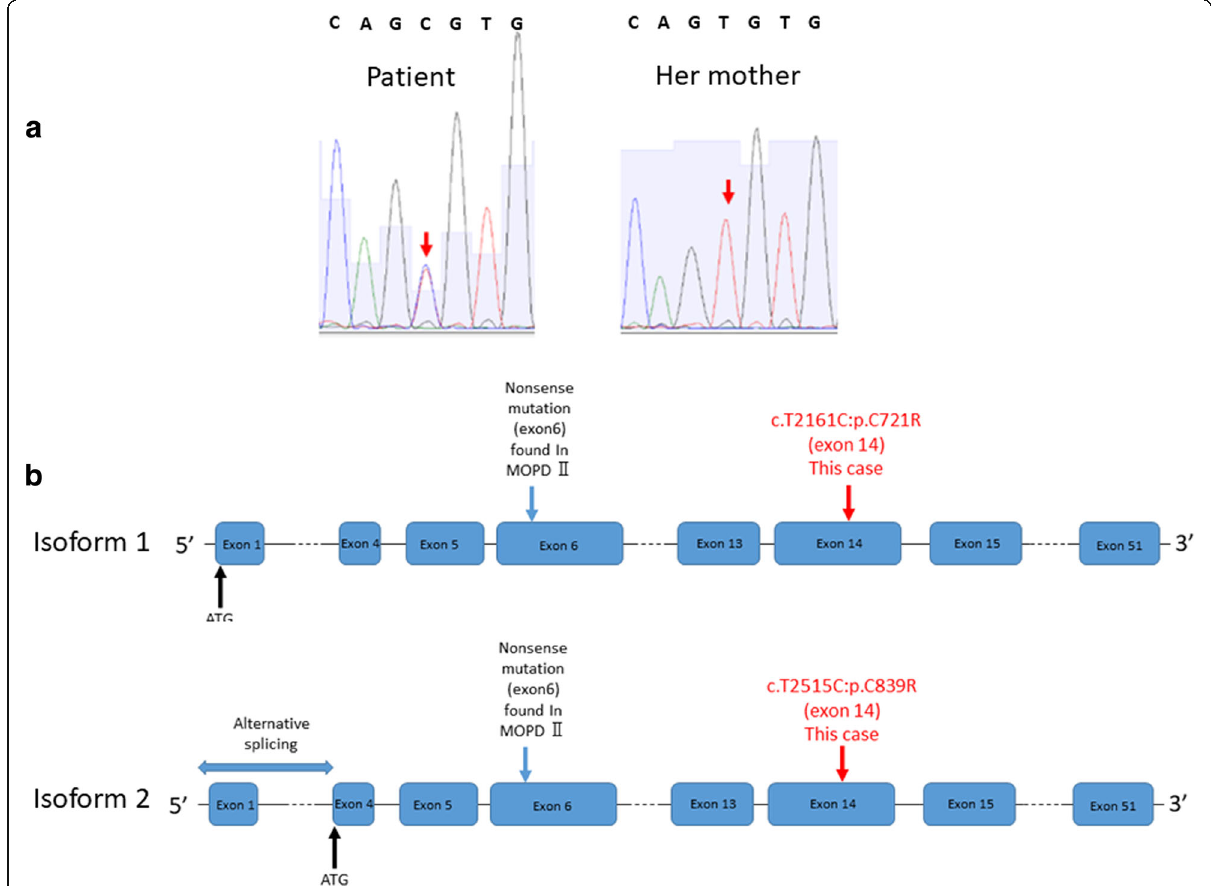
Fig. 5 Missense variant present in exon 14. The variant was determined to be PCNT : NM_006031, exon 14, c.T2515C, p.C839R;